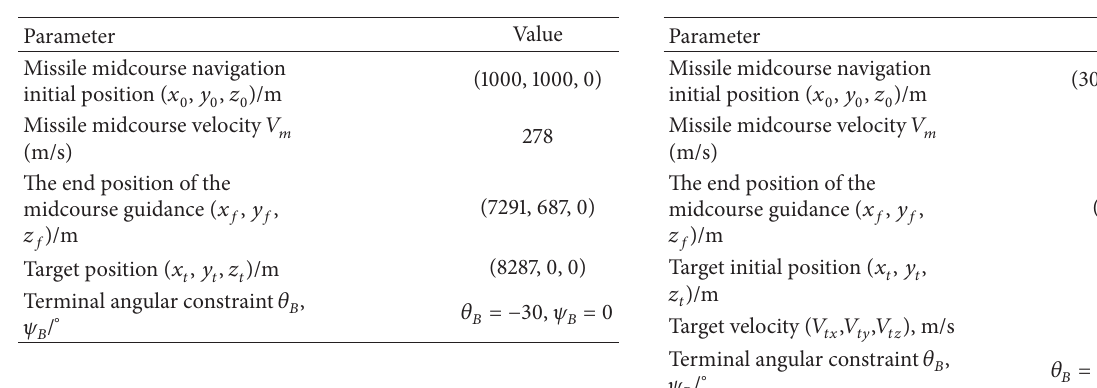
Table 6: Conditions for the simulations (fixed target). Table 7: Conditions for the simulations (moving